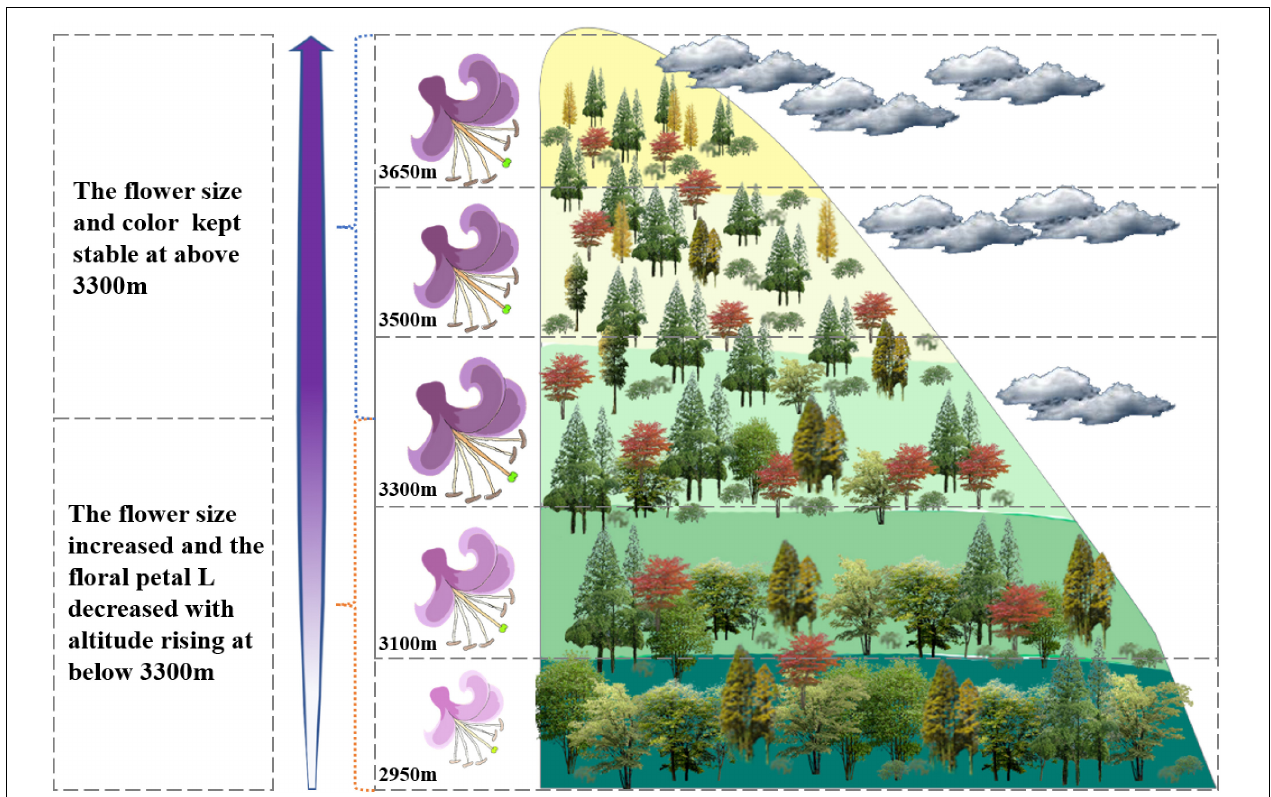
FIGURE 6 | Diagrammatic sketch of the transformation on floral size and color of Lonicera nervosa . The flowers of L. nervosa tended to be larger and darker along the altitude; however, the floral display appeared to be largest at an altitude of around 3,300 m, and the petal color lightness was kept stable at above 3,300